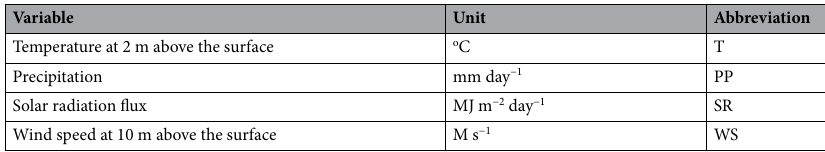
Table 1. Agrometeorological variables of the AgERA5 data set used in this